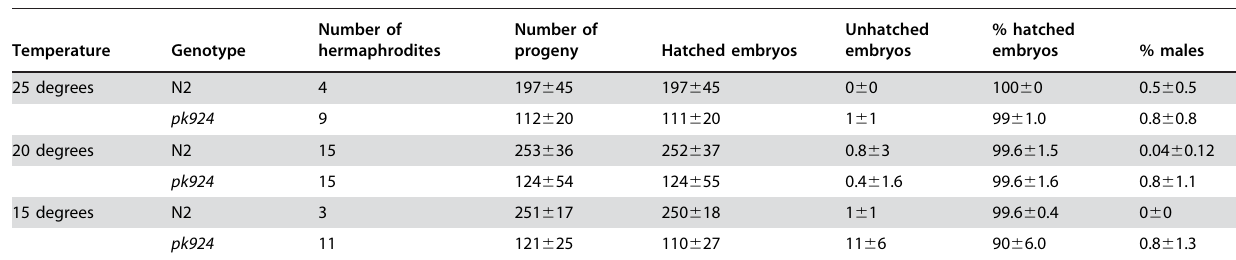
Table 1. Progeny, viability, and incidence of males analysis at 25, 20, and 15 degrees. .. ... .... ... ... .... ... ... .... ... ... .... ... ... .... ... ... .... ... ... .... ... ... .... ... ... .... ... ... .... ... ... .... ... ... .... ... ... .... ... ... .... ... ... . Temperature